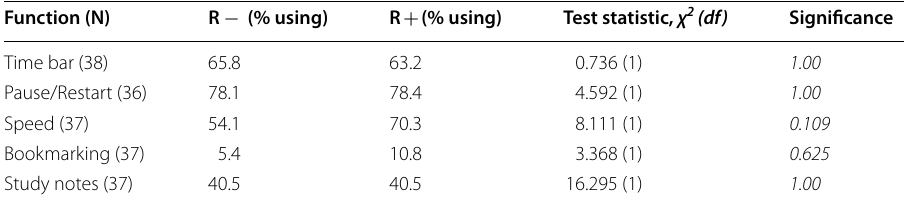
Table 4 Percentage of students using specific functions of lecture capture